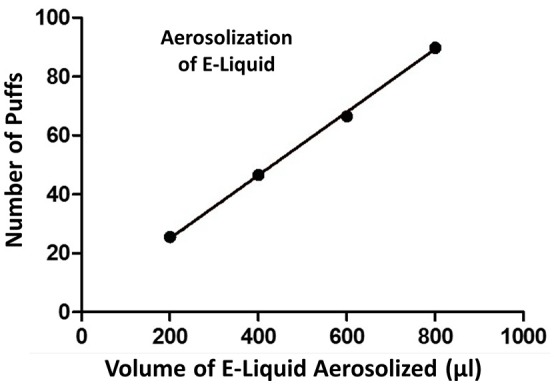
Number of puffs on the ECIG device as a function of volume (μl) of E-liquid aerosolized. Pearson r = 0.9995 and p < 0.005.